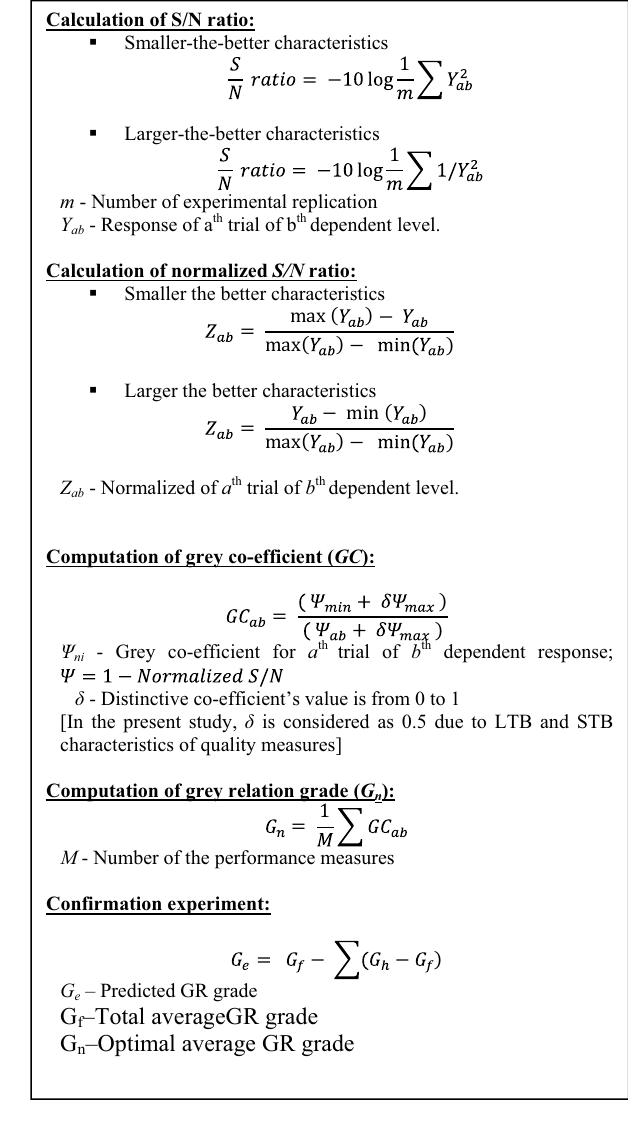
Figure 6: TGRA - based methodology in PMEDM